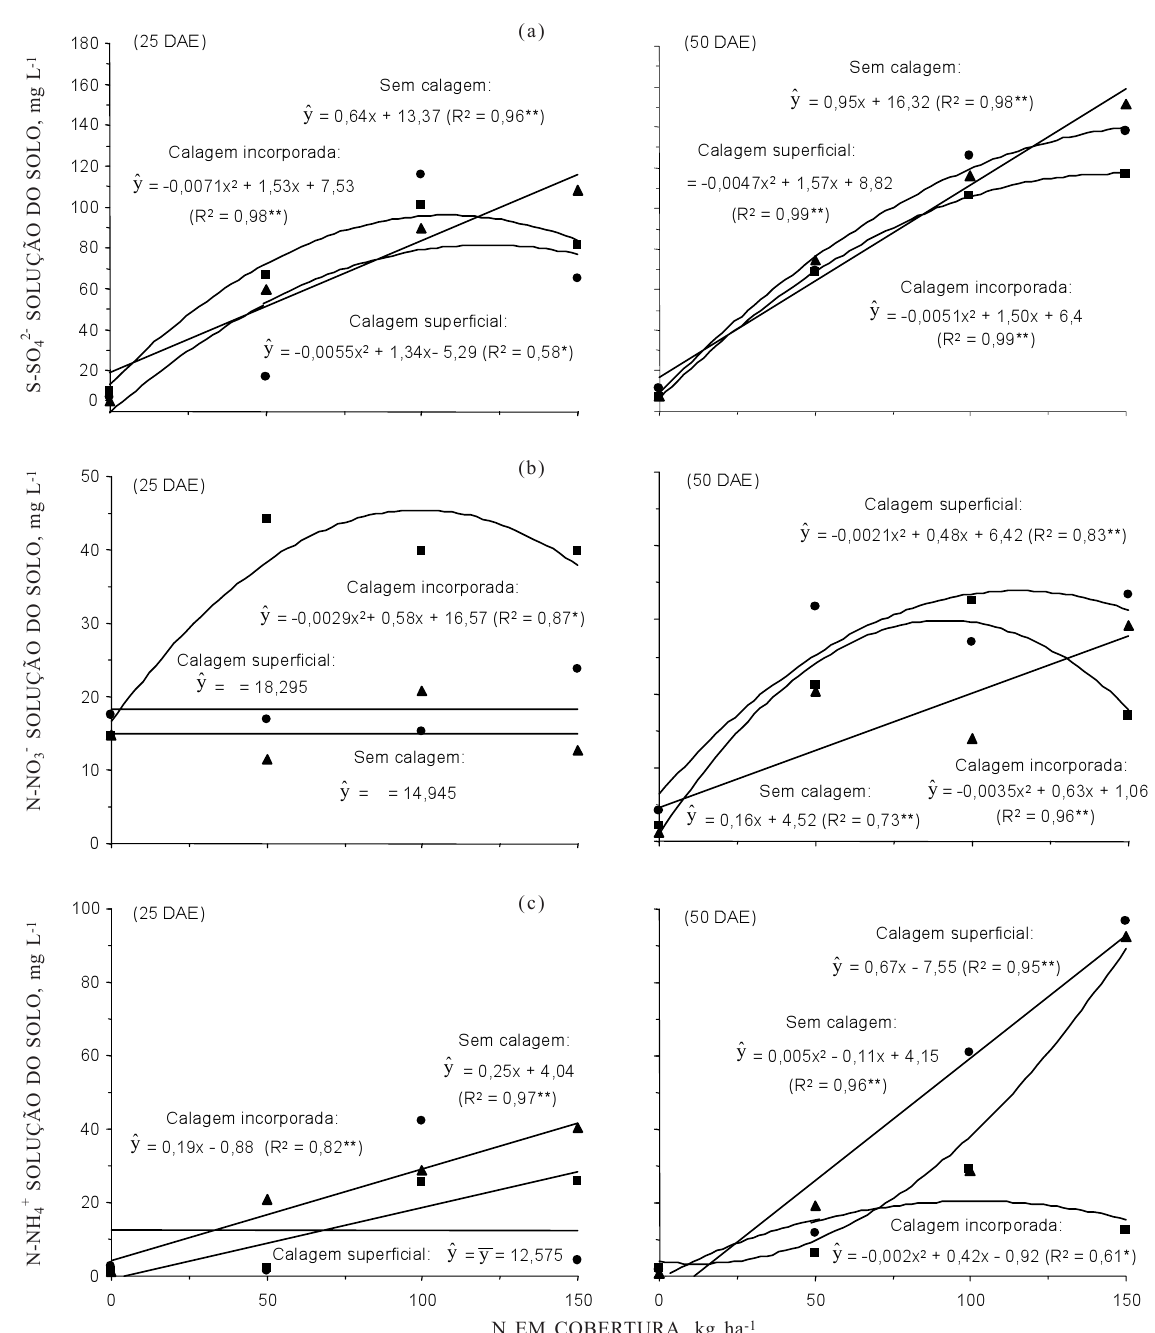
Figura 1. Concentrações de S-SO 42- (a), N-NO 3- (b) e N-NH 4+ (c) na solução do solo, em função das doses de N aplicadas em cobertura, nas condições de calagem superficial ( ), calagem incorporada ( ) e sem calagem ( ), aos 25 e 50 DAE do algodão. * e ** significativos a 5 e 1 %, respectivamente. ns: